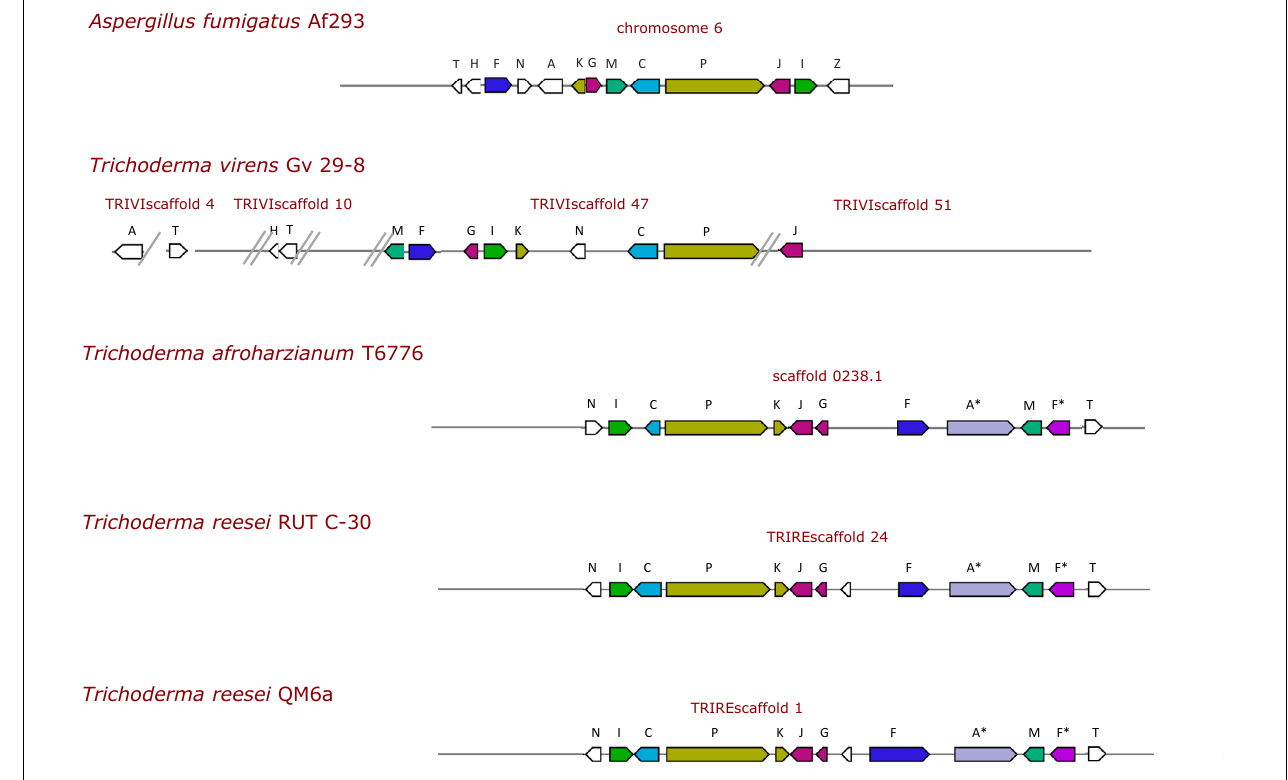
FIGURE 1 | Schematic view of the gliotoxin biosynthesis genes (GT-BG) in A. fumigatus and representative Trichoderma spp. strains. Arrows represent the genes, and their size is proportional to the length of the corresponding genomic region. The GT-BG are gliZ (Z), zinc finger transcription factor; gliI (I), 1-aminocyclopropane-1-carboxylate synthase; gliJ (J), a dipeptidase; gliP (P), a two-module non-ribosomal peptide synthetase (NRPS); gliC (C), gliF (F), two cytochrome P450 monooxygenases; gliF * (F*), second putative ortholog; gliM (M), O -methyltransferase; gliG (G), a glutathione- S -transferase; gliK (K), a cyclotransferase (GGCT); gliA (A) or gliA * (A*), respectively, major facilitator superfamily (MFS) or ATP-binding cassette (ABC) transporter; gliN (N), a methyltransferase; gliT (T), a GT oxidase; gliH (H), coding a conserved hypothetical protein. The scaffolds containing the GT-BG are separated by double lines at their extremities; a single line indicates that the genes are present in the same scaffold but not clustered.